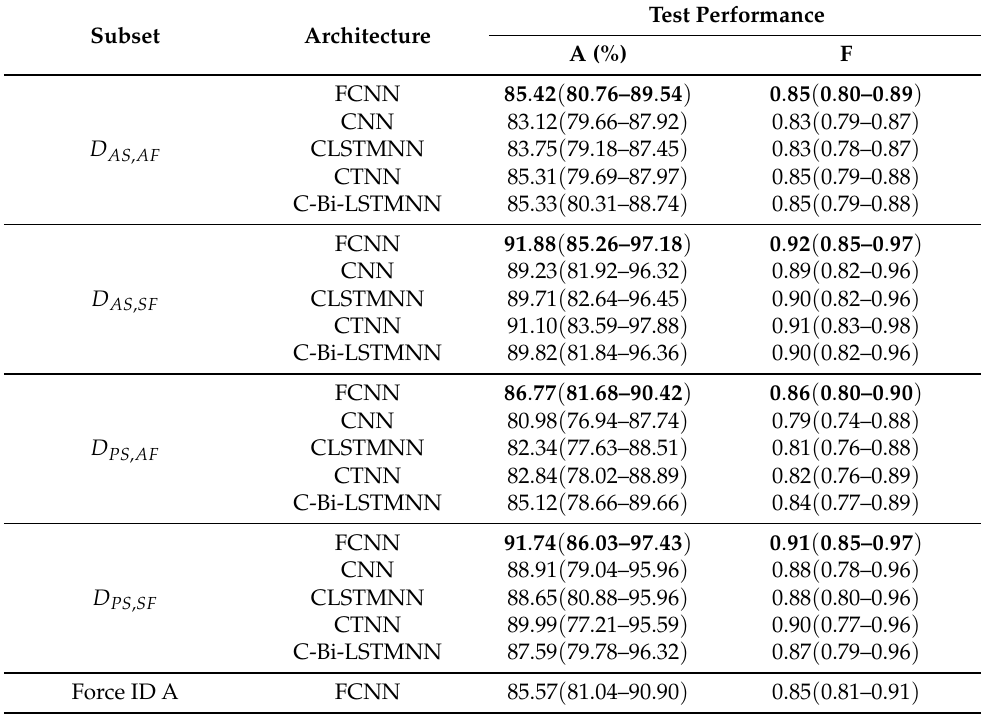
Table 3. Accuracy (A) and F1 score (F) of each deep neural network architecture on each data subset ( D ) over seven-fold cross-validation (provided as mean and min–max range over test sets with the best results in bold). The results for the fully connected neural network (FCNN) architecture on ForceID A are also given as a benchmark. CNN = convolutional neural network, CLSTMNN = convolutional long short-term memeory neural network, CTNN = convolutional transformer neural network, C-Bi- LSTMNN = convolutional bi-directional long short-term memory neural network, AS = all speeds, PS = preferred speed, AF = all footwear, SF = same footwear (between sessions). Subset